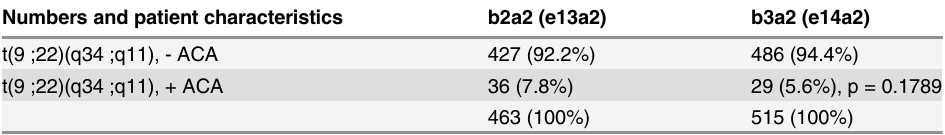
Table 1. Occurrence of ACA in CML patients (n = 978) of the randomized CML Study IV during long term treatment with IM. Numbers and patient